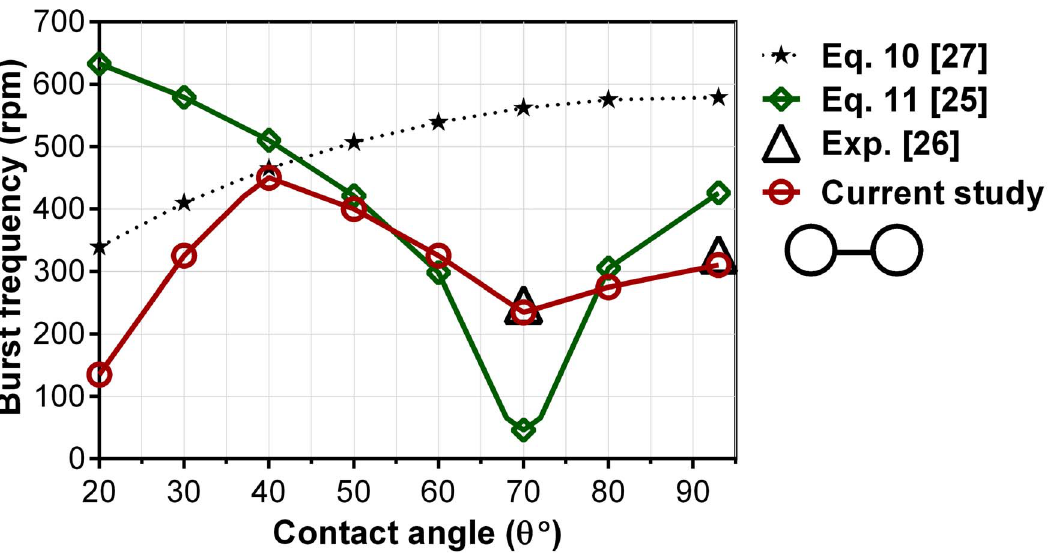
Figure 7. Burst frequency from the CFD model, Eq. 10 [27] & Eq. 11 [25] versus contact angles for Cases 11–18. Experiment results from He et al. [26] is also given.